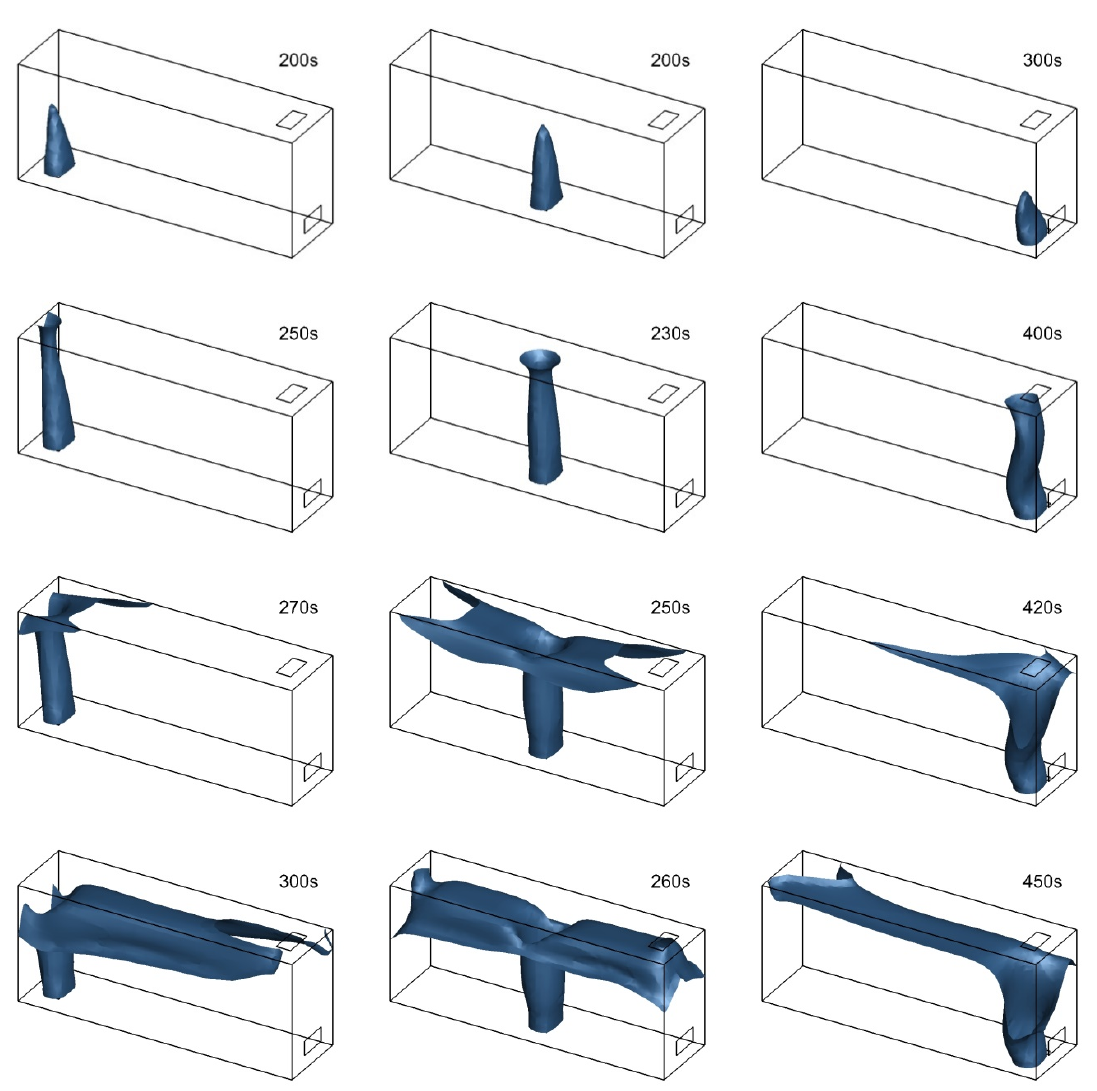
Figure 2. Iso-surface of 4% hydrogen mole fraction for Model 1 (left), Model 2 (middle), and Model 3 (right). The velocity vectors in the median plane z = 0.37 of the envelope of the iso-surfaces of 4% mole fraction rising to the ceiling is illustrated in Figure 3. The distance between the leak position and the bottom vent in Model 2 is farther than that in Model 3, but closer than that in Model 1. From the results of the velocity vector shown in the circulation zone between the leakage position and the ceiling, the fastest vertical speed (approximately 0.33 m/s) was in Model 2. It contributed to the shortest time spent by Model 2 during the first phase. In the case of Model 3, the top vent is above the leakage position, and a large amount of hydrogen is discharged. Therefore, it takes a longer time for the iso-surface of 4% mole fraction to diffuse to the ceiling (Figure 3).